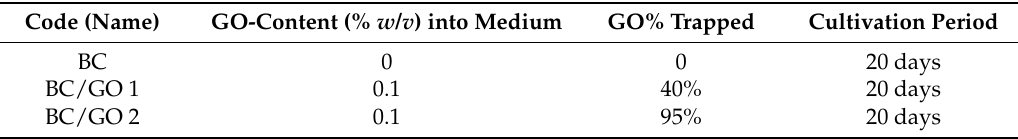
Table 1. Sample code, GO-content, percentage of GO trapped and cultivation period.